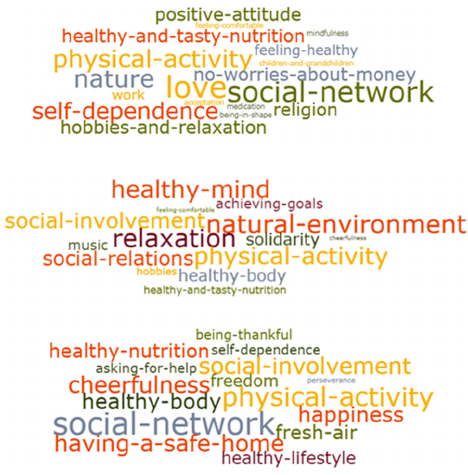
Figure 1. Word clouds of three different groups.